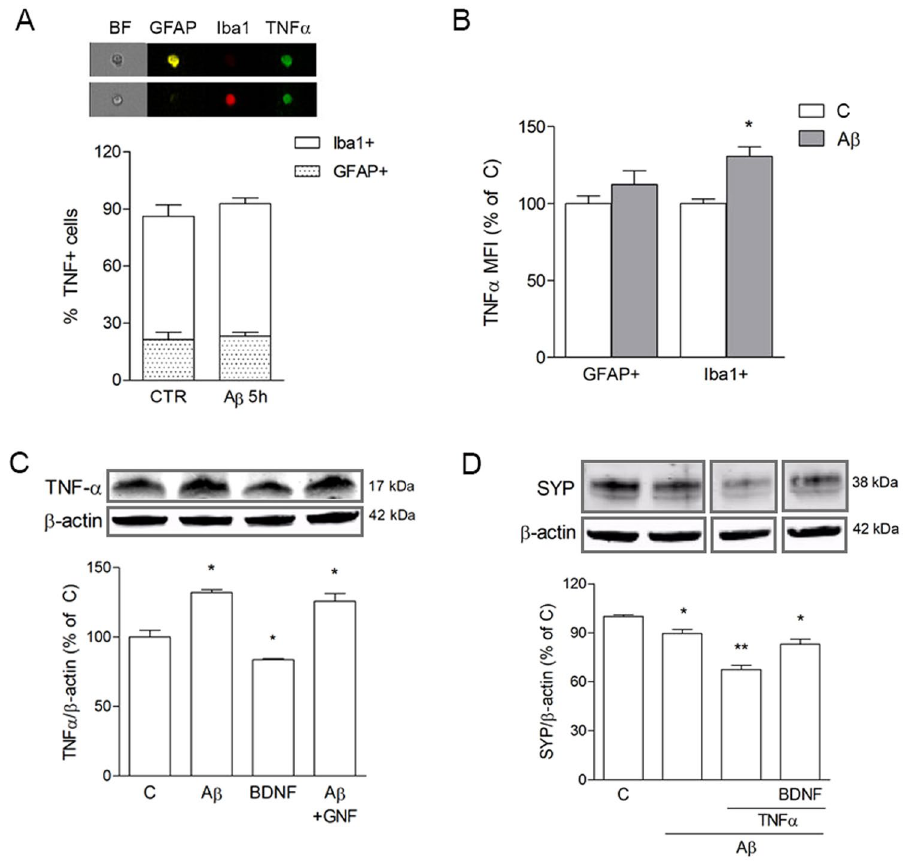
Figure 4. Microglial TNF- α is induced by A β 42 independently of BDNF. pMG were treated with A β 42 (0.5 μ M) for 5 h. Co-localization of TNF- α with Iba1 or GFAP in mxG cells was determined by triple immunostaining followed by image cytofluorometric analysis of the percentage of immunopositive cells ( A ) and mean fluorescence intensity of TNF- α (MFI; B ). BF = brightfield. Western blot analysis of TNF- α in pMG treated with BDNF (1 ng/ml for 24 h) or with A β 42 (0.5 μ M for 5 h) alone or in combination GNF (100 nM; C ). Western blot analysis of SYP in SH-SY5Y cells treated with A β 42 (0.5 μ M for 5 h) alone or in combination with TNF- α (10 ng/ml) and BDNF (1 ng/ml) ( D ). Blots were cropped to display specific bands. Original blots are reported in Supplementary Fig. 3. Values are mean ± SEM with n = 3–5. * p < 0.05 vs. untreated control by one- way ANOVA followed by Newman-Keuls test for